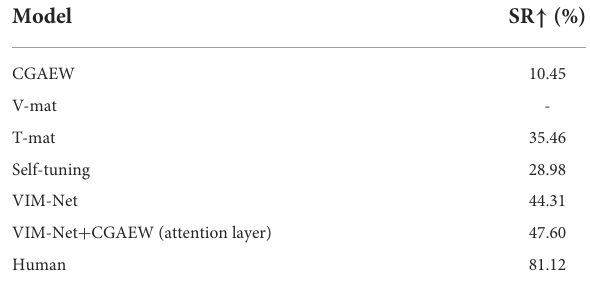
TABLE 6 The ablation study of our proposed architecture on the RUN datasets and comparison with other